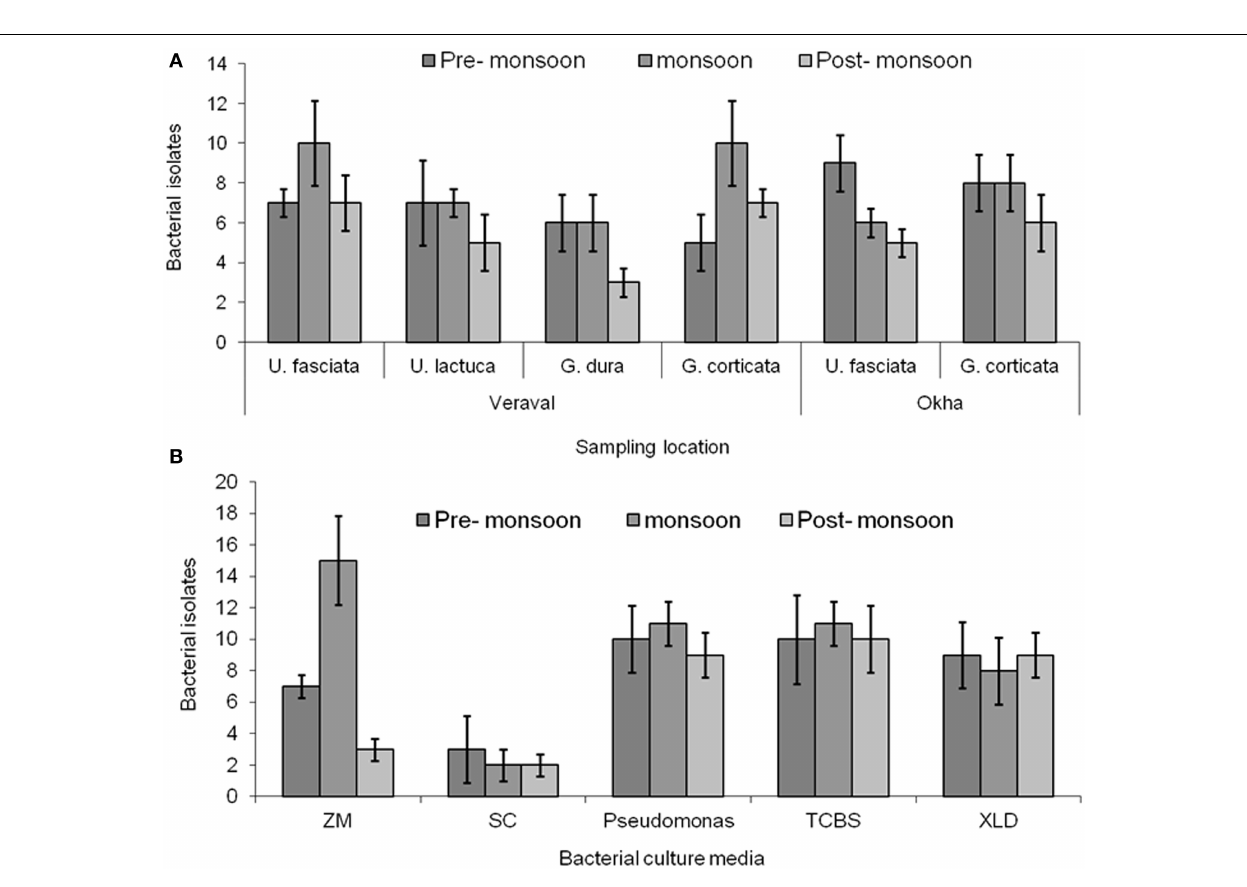
AHLs (C 4 -HSL, HC 4 -HSL, C 6 -HSL, 3- oxo -C 6 -HSL, and 3- oxo -